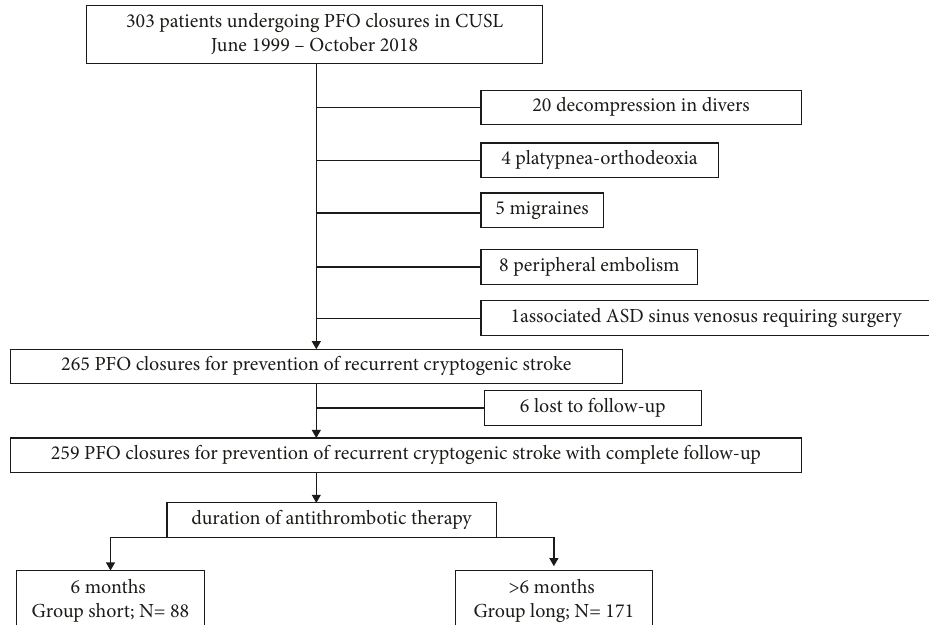
Figure 2: Study flow chart. ASD, atrial septal defect; CUSL, Cliniques universitaires Saint-Luc, PFO, patent foramen